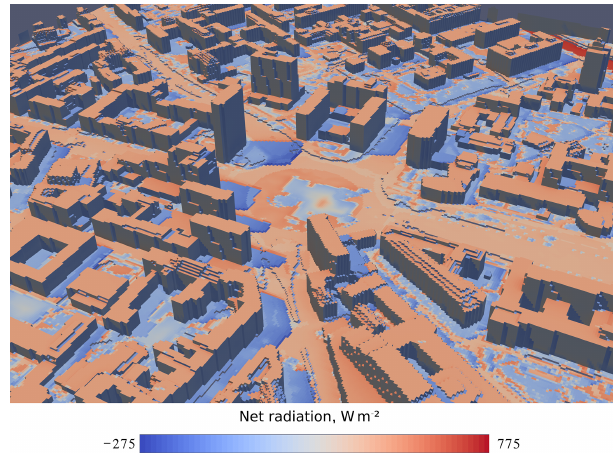
Figure 7. Surface net radiation flux in a built-up city quarter (Ernst- Reuter-Platz, Berlin, Germany) on 1 July 2009 at 14:00UTC. Back- ground: building height data created by DLR based on CityGML data from FIS Broker Berlin (https://www.stadtentwicklung.berlin. de/geoinformation/fis-broker/, last access: 18 February